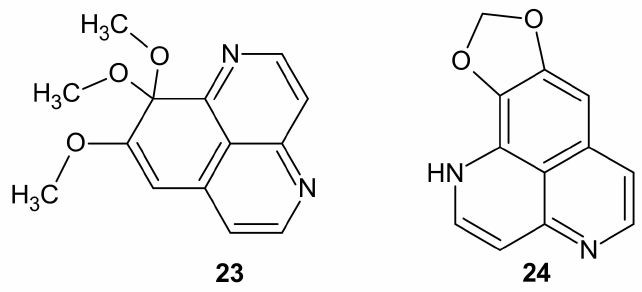
Figure 7. Structure of 8,9,9-trimethoxy-9 H -benzo[ de ][1,6]naphthyridine 23 and 1,3-dioxolo[4,5- d ]benzo[ de ][1,6]naphthyridine 24